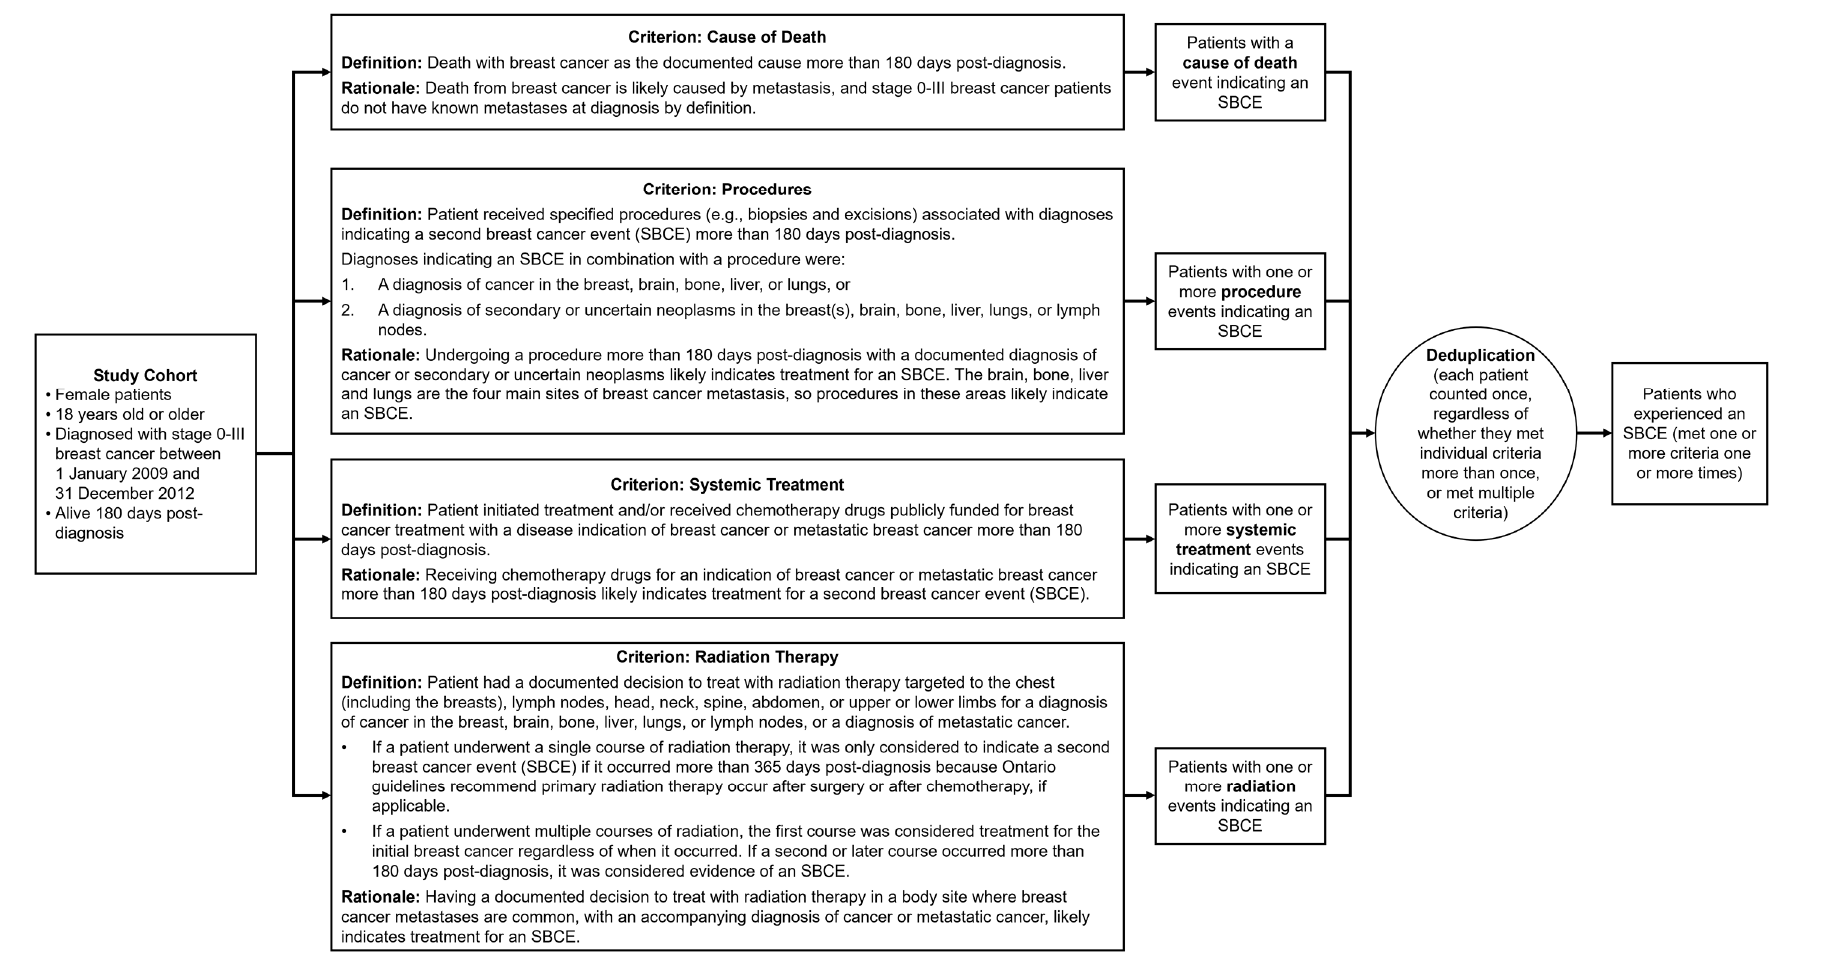
Figure 1. Algorithm criteria with definitions and rationale. Each criterion was applied to the entire study cohort. Patients could meet a single criterion multiple times or meet multiple criteria. For this study, we considered patients to have experienced a second breast cancer event (SBCE) if they met one criterion one time between 180 days post-diagnosis and their death or the end of follow-up.